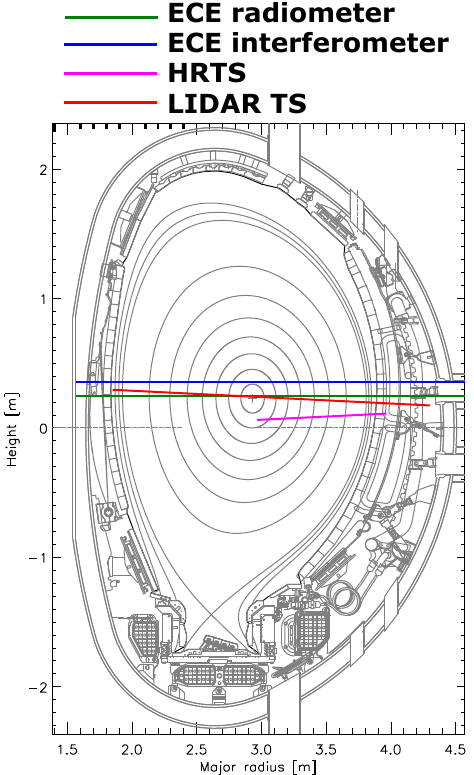
Figure 1: Lines of sight of the main electron temperature diagnostics on